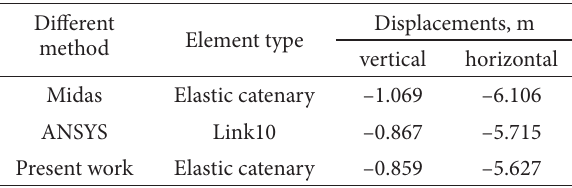
Table 3. Comparison of displacements of isolated cable under concentrated load